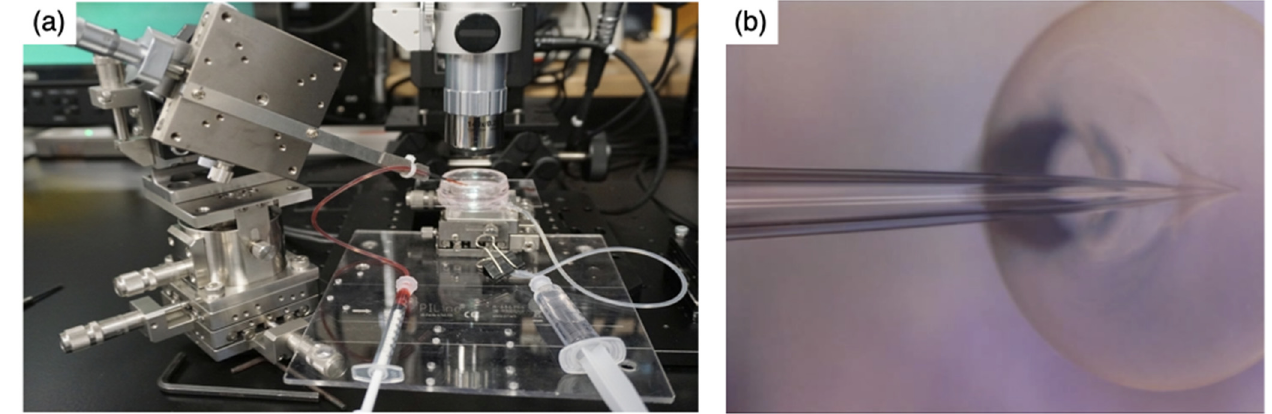
Figure 1. Photographs of the injection system. ( a ) The injection equipment; ( b ) injection into the ChG2 capsule using a glass micropipette.